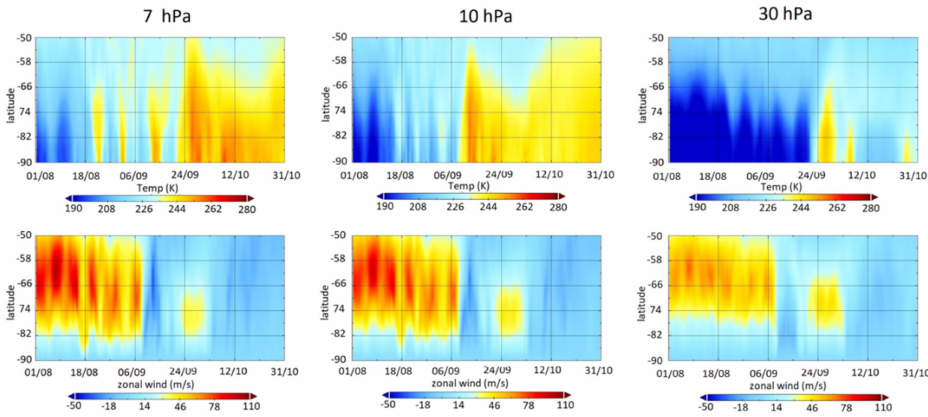
Figure 4. Zonal mean of temperature ( upper panels ) and zonal wind ( bottom panels ) for 7, 10, and 30 hPa during period 1 January 2009–31 March 2009.